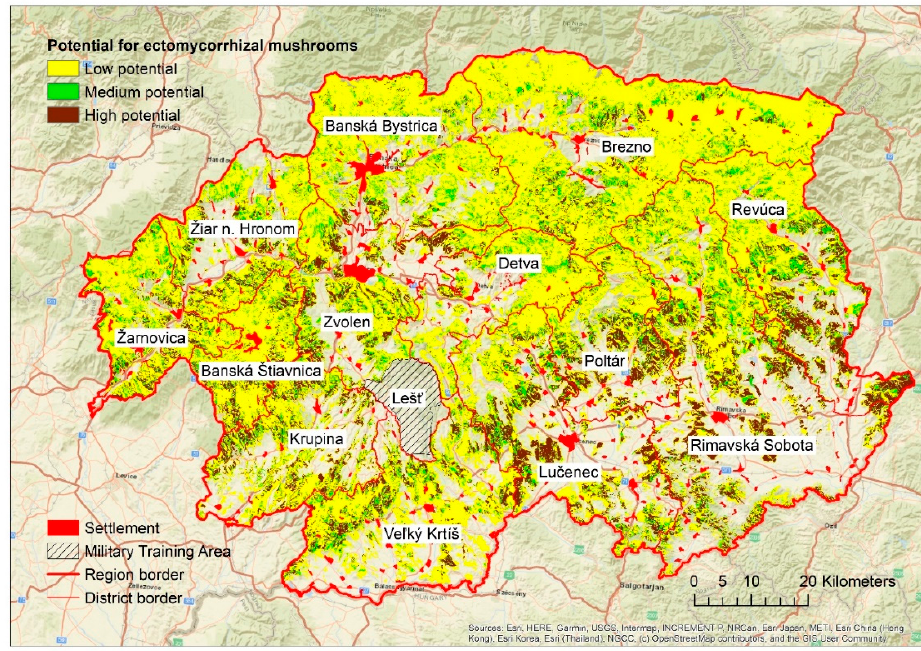
Figure 2. Potential of forest stands for ectomycorrhizal mushrooms growing in the Banskobystrický Self-governing Self-governing Region. Table 2. Potential of forest stands for ectomycorrhizal mushrooms growing.